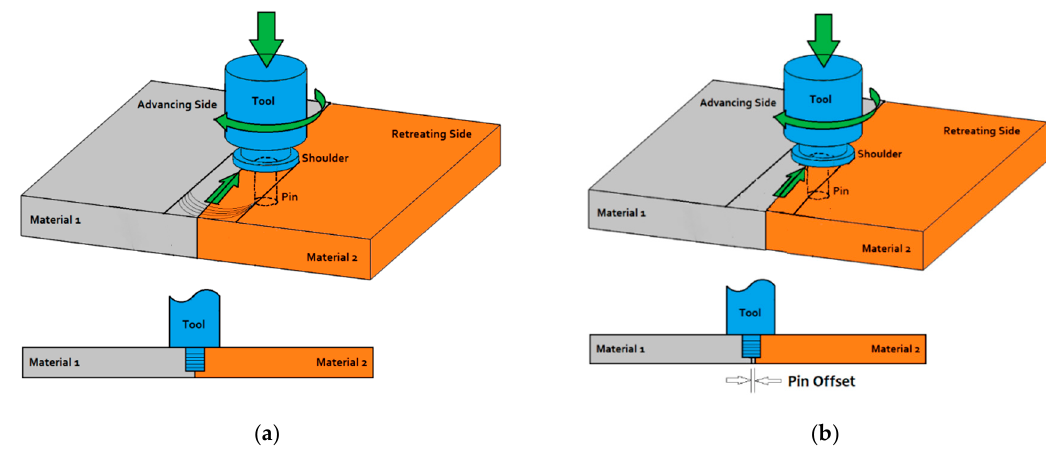
Figure 2. Schematic showing configuration for joining dissimilar materials using a friction stir welding process. ( a ) No tool offset, ( b ) Existence of tool offset.